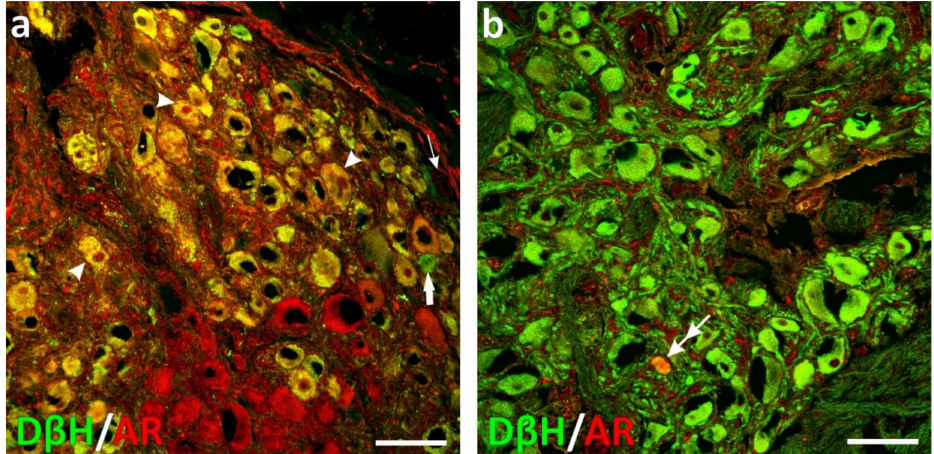
Figure 3. Confocal laser scanning microscope images showing the distribution of AR-positive (AR+; red; Alexa 555 visualization (A555)) and dopamine- β -hydroxylase+ (green; Alexa 488 visualization (A488)) neurons in sections from APG ( a ) and CSMG ( b ) in the adult male pigs. Green and red channels were superimposed (GRDS), double-labeled elements are yellow to orange. In APG, nearly all D β H-positive and many D β H-negative neurons exhibited cytoplasmic and nuclear AR immunoreactivity; arrowheads show some AR-positive neuronal nuclei. Thin and thick arrows show D β H-negative/AR-negative and D β H-positive/AR-negative neurons, respectively. In CSMG, only solitary neurons (double arrow) stained for AR. Bar in all images—100 µ m; Figure 3 is adapted from Kaleczyc et al.